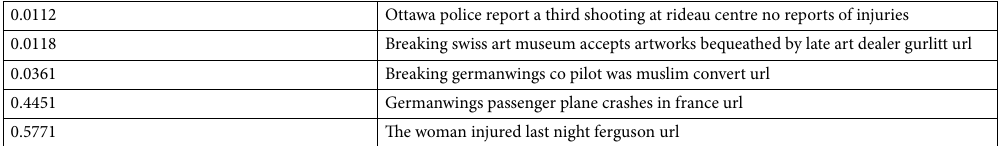
′ ′ ′ ′ , AN for acceptor, and DP , DN , DP , DN for donor. A and D indicate